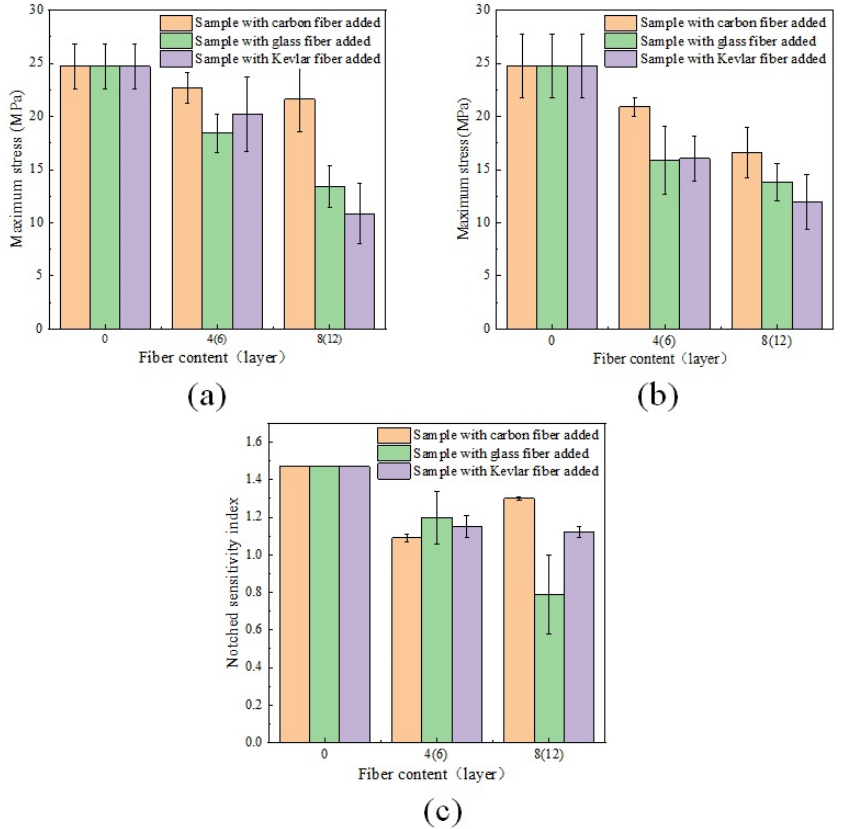
Figure 10. ( a ) Maximum strain diagram of three kinds of fiber un-notched samples, ( b ) maximum strain diagram of three kinds of fiber center-notched samples, ( c ) notched sensitivity index diagram of three kinds of fiber un-notched samples.